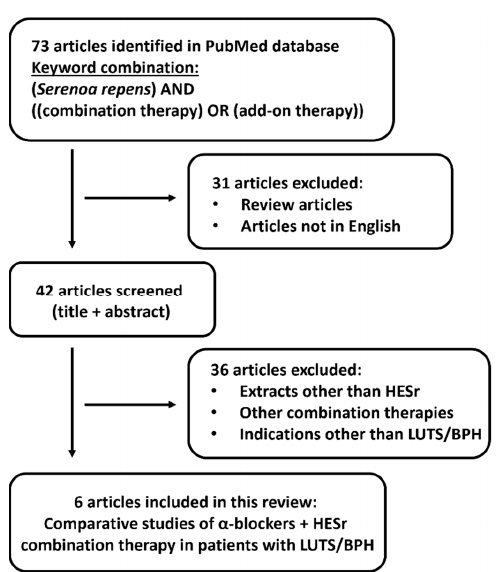
Figure 1. Flowchart of the study selection process. HESr—hexanic extract of Serenoa repens . LUTS/BPH—lower urinary tract symptoms associated with benign prostate hyperplasia.